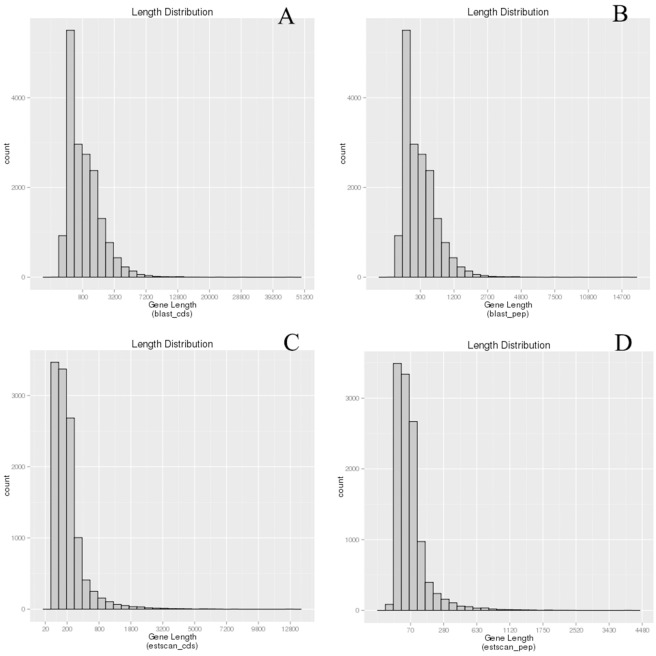
Coding sequence predictions of C. Ciliata transcriptome by BLASTx and ESTScan.(a) Length distribution of CDs using BLASTx (E-value < 10−5); (b) Length distribution of proteins using BLASTx; (c) Length distribution of CDs predicted by ESTScan, and (d) Length distribution of proteins using ESTScan.